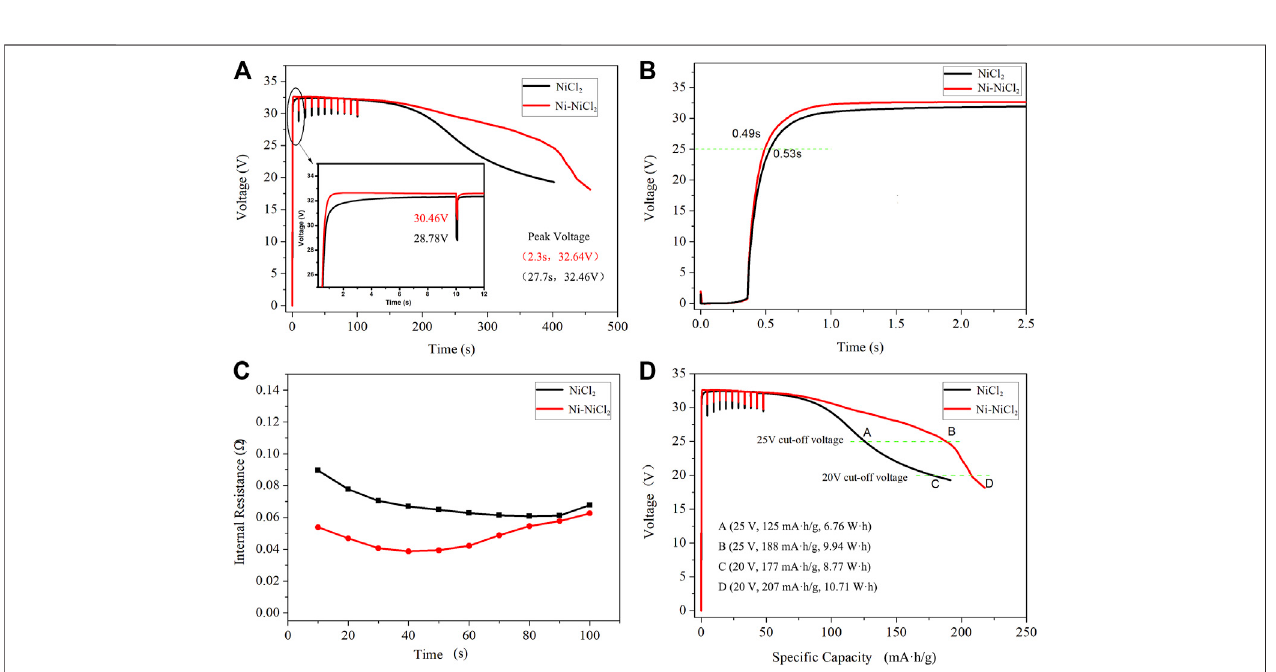
FIGURE5| Dischargetestresultsofthermalbatteryassembledusing13cellsataconstantcurrentdensityof100 mA/cm 2 andthepulsecurrentdensity(1 A/cm 2 , 10 ms)loadedevery10 s. (A) Voltage – timecurveofNiCl 2 andNi-NiCl 2 , (B) theactivationprocess, (C) voltage-speci fi ccapacitycurvesofNiCl 2 andNi-NiCl 2 ,andthe (D) internal resistance – time curves of NiCl 2 and Ni-NiCl 2 .